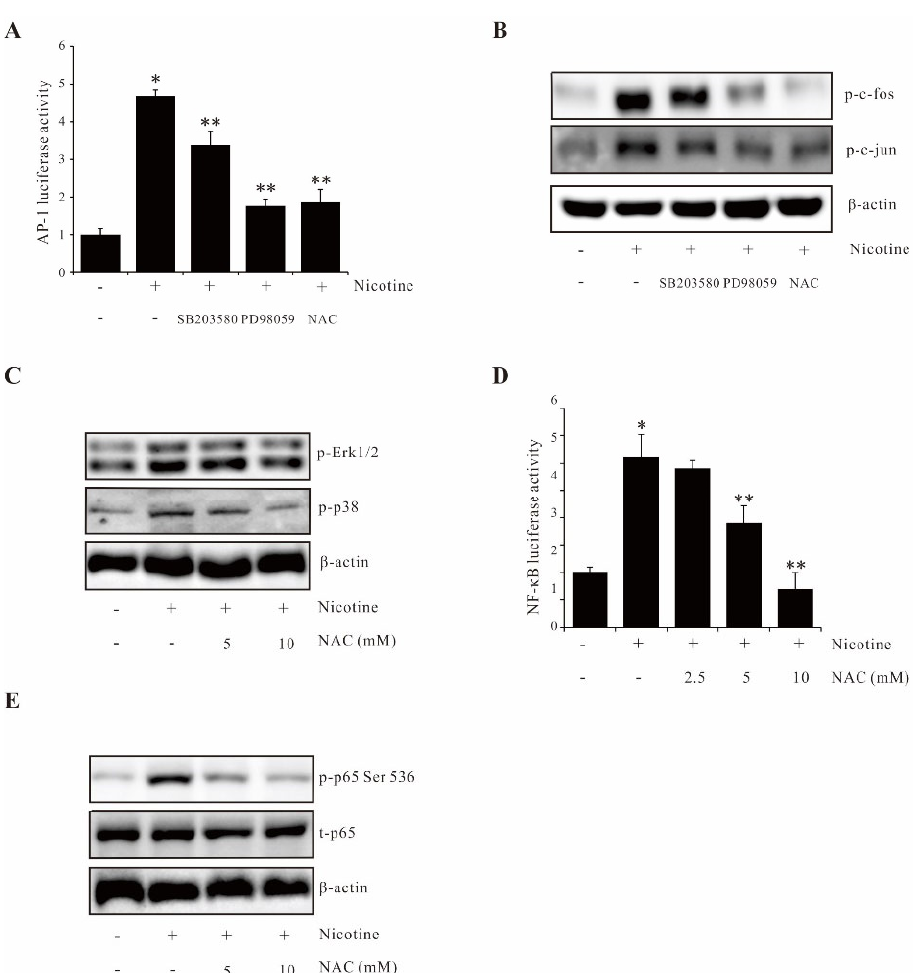
Figure 5. ROS/(p38 MAPK, Erk1/2) and ROS functioned as upstream regulators of AP-1 and NF- κ B, respectively. ( A ) AGS cells were transfected with the AP-1 luciferase reporter. The luciferase activity was determined using a luminometer after incubating the cells with 20 µ M SB203580, 20 µ M PD 98059, or 5 mM NAC for 1 h prior to nicotine treatment for 4 h. ( B ) AGS cells were pretreated with 20 µ M SB203580, 20 µ M PD 98059, or 5 mM NAC and treated with 100 µ g/mL nicotine for 30 min; the expression of phos-c-fos and phos-c-jun were analyzed by Western blot. ( C ) Cells were pretreated with the indicated concentration of NAC and treated with 100 µ g/mL nicotine for 30 min; the expression of phos-Erk1/2 and phos-p38 were analyzed by Western blot. ( D ) Cells were transfected with the NF- κ B luciferase reporter. The luciferase activity was determined using a luminometer after incubating the cells with NAC for 1 h prior to nicotine treatment for 4 h. ( E ) Cells were pretreated with the indicated concentration of NAC and treated with 100 µ g/mL nicotine for 30 min; the expression of phos-p65 (Ser5360 and phos-I κ B α (Ser32) were analyzed by Western blot. The data represent the mean ± SEM from three experimental trials. * p < 0.05 in comparison with the control; ** p < 0.05 in comparison with nicotine alone.